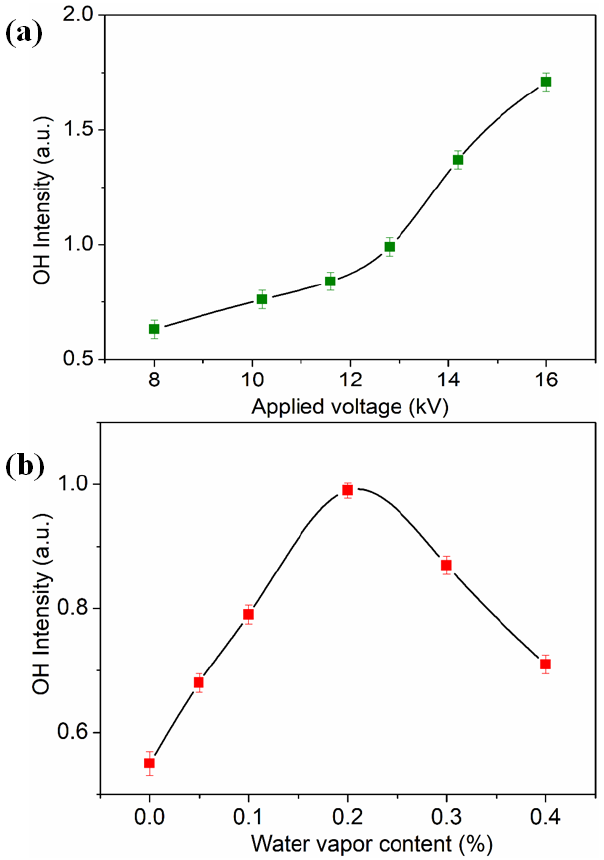
Figure 4. Variation in the intensity of OH spectra with different ( a ) applied voltages (water vapor content: 0.2%) and ( b ) water vapor content (applied voltage: 12.8 kV).